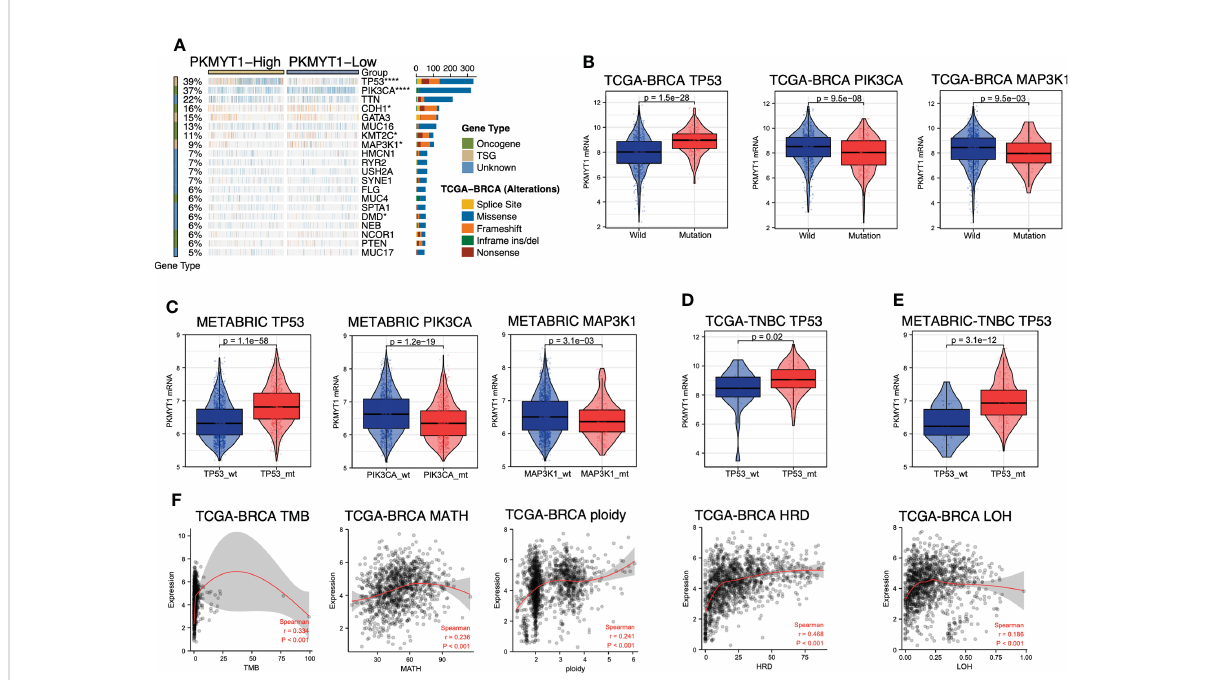
FIGURE 6 PKMYT1 was associated with key gene mutation and genomic molecular changes. (A) The waterfallmap from the TCGA-BRCA multi-omics cohort showed different mutant landscapes in high- and low-expression PKMYT1 groups; (B, C) PKMYT1 mRNA expression in TP53, PIK3CA and MAP3K1 mutation/wild-type group of TCGA-BRCA and METABRIC cohort; (D, E) PKMYT1 mRNA expression in the TP53 mutant/wild-type group of METABRIC and TCGA TNBC patients. (F) The Spearman correlation between PKMYT1 mRNA expression and genomic heterogeneity in TCGA cohort, including TMB (Tumor Mutation Burden), MATH (Mutant- Allele tumor heterogeneity), ploidy, HRD (Homologous recombination de fi ciency), and LOH (Loss of heterozygosity). * p < 0.05, **** p <